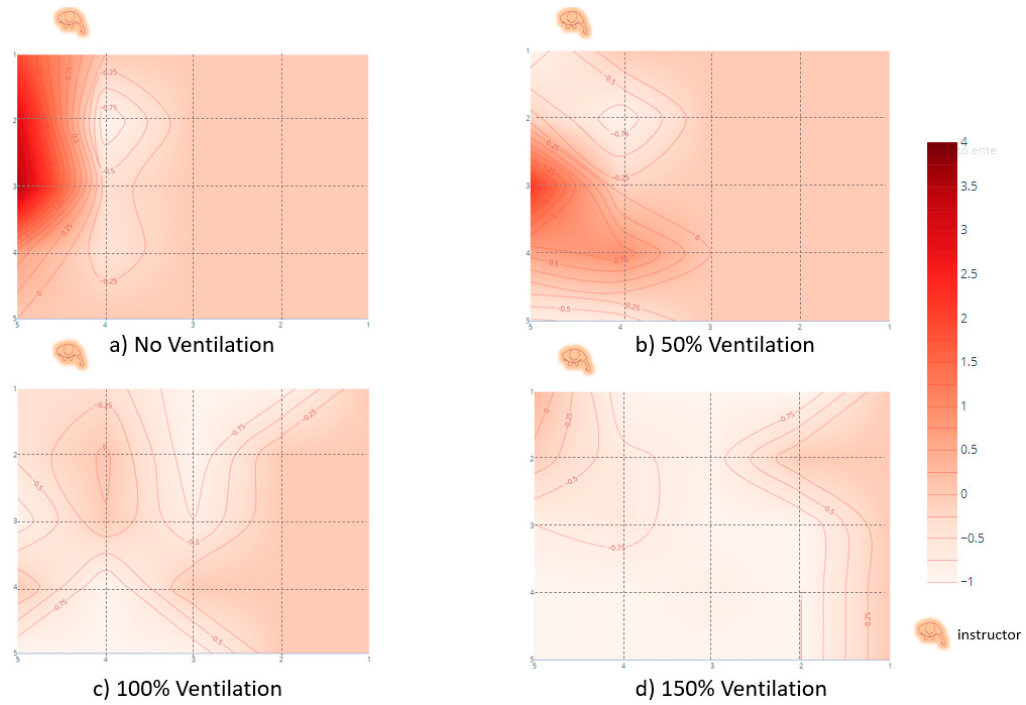
Figure 13. The exceedance in exposure ratio ( EER ) after 180 s.